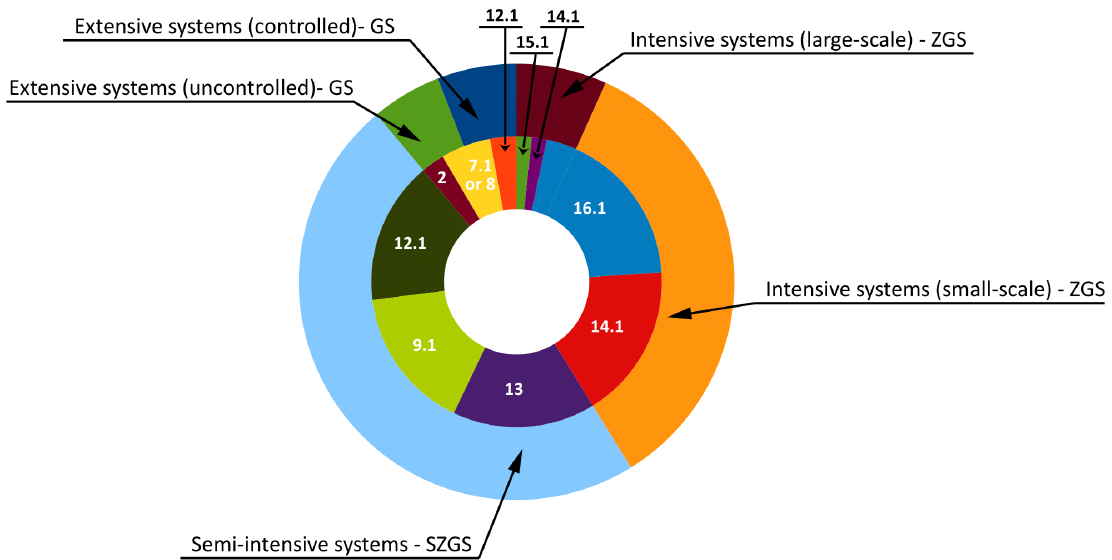
Figure 5. Share of dairy production systems. Outer circle: dairy systems according to literature [29,30]. Inner circle: dairy systems according to the typology.